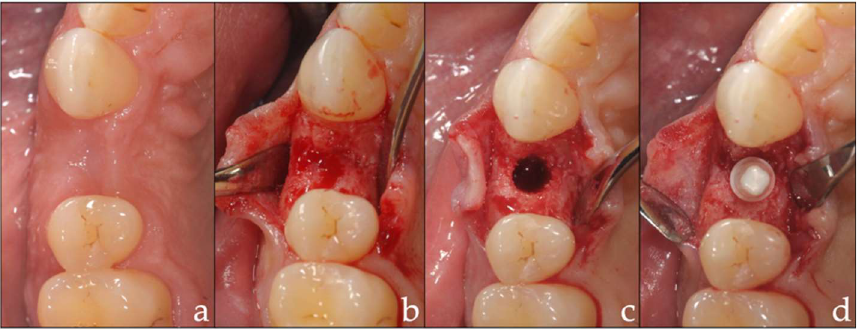
Figure 1. ( a – d ) Implant surgery: ( a ) initial situation; ( b ) flap elevation; ( c ) drilling procedure; ( d ) implantation.